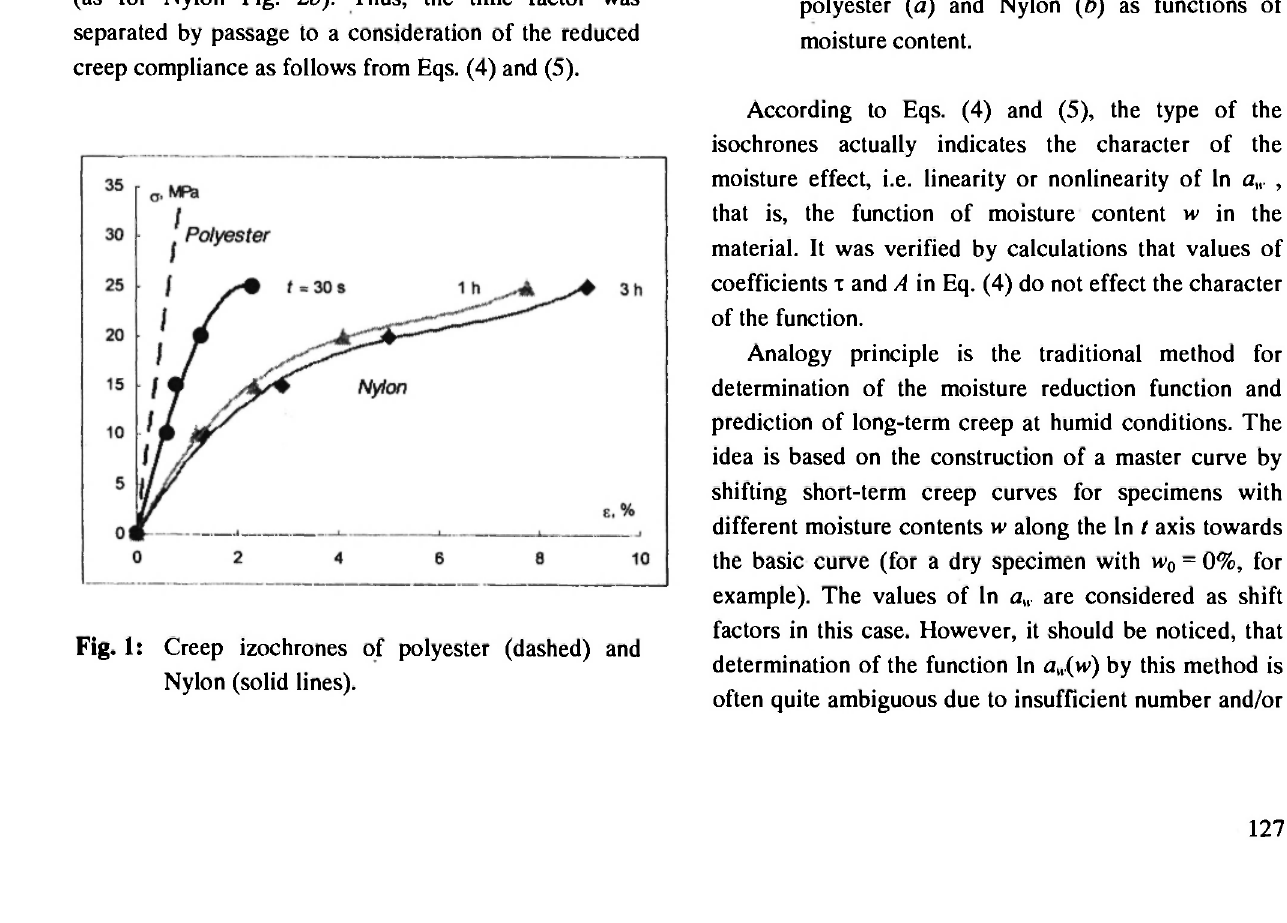
Fig. 2: Isochrones of the reduced compliance for polyester (a) and Nylon (b) as functions of moisture